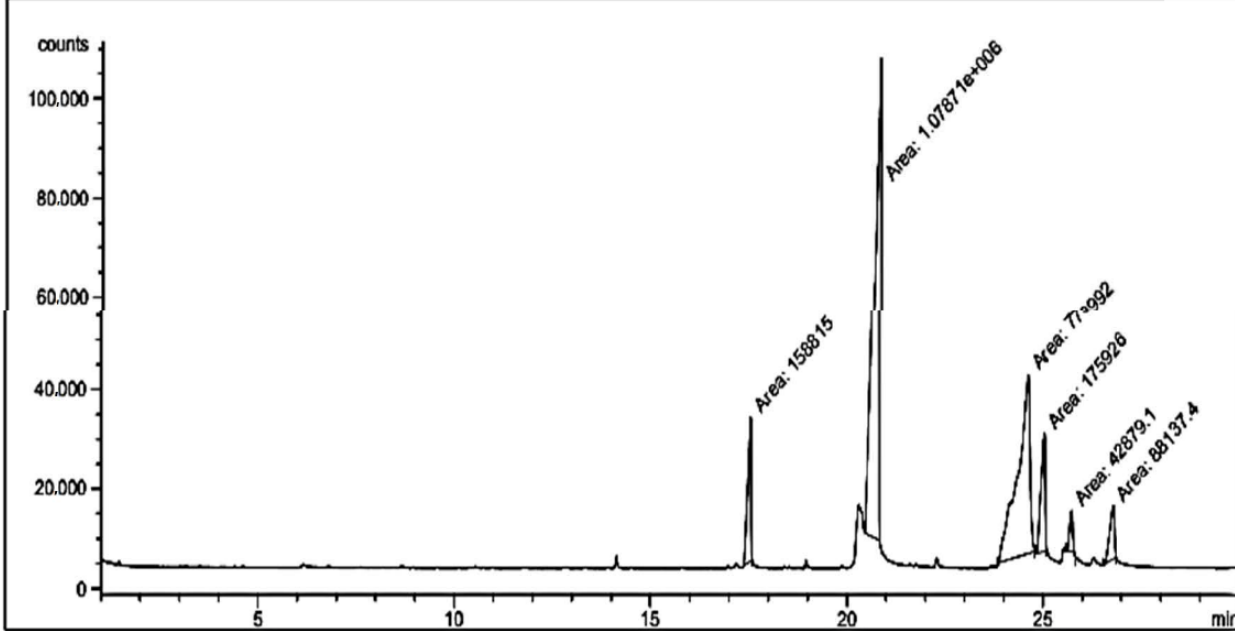
Figure 4. 13 C NMR spectrum recorded in CDCl 3 of the isolated biosurfactant of Candida sphaerica cultivated in medium supplemented with 9% vegetable oil refinery residue and 9% corn steep liquor.